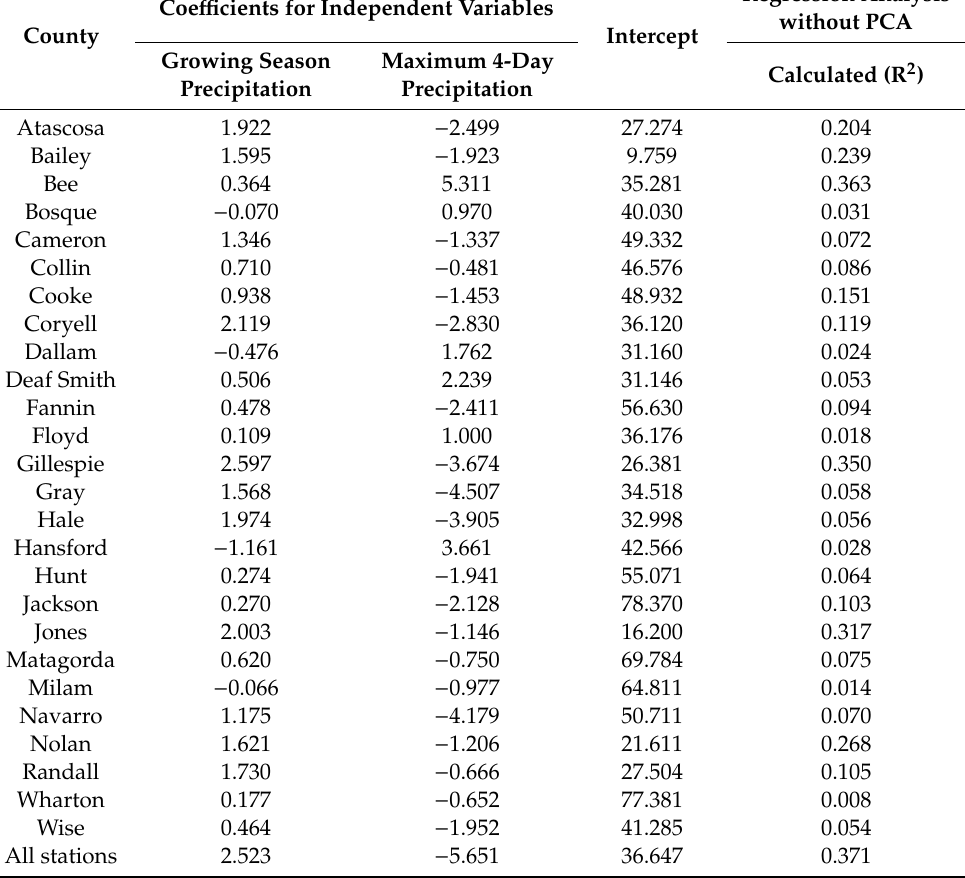
Table 5. Results of multiple linear regression analysis (without principal component analysis) using annual growing season precipitation, 4-day maximum precipitation, and crop